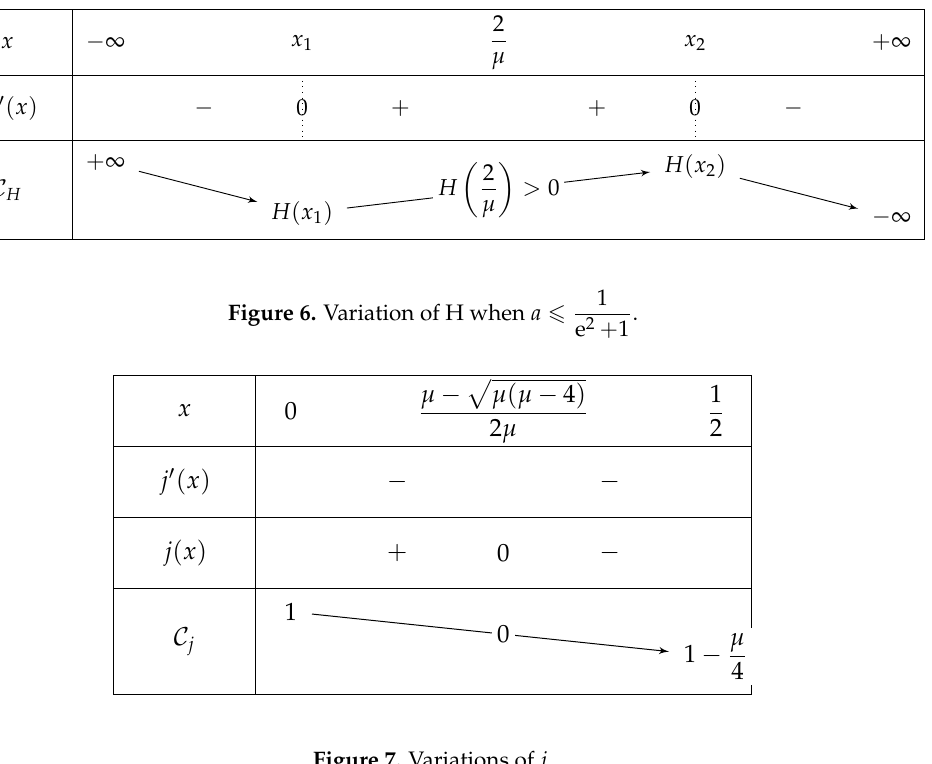
Figure 7. Variations of j